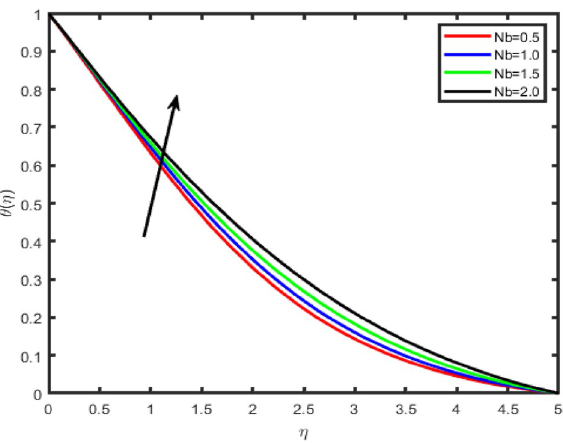
Figure 20. Effect of Brownian motion parameter (Nb) on temperature